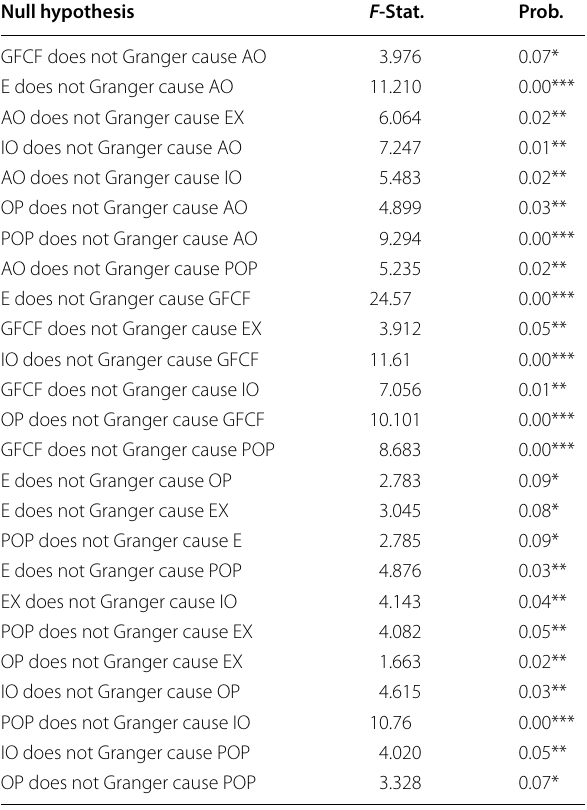
Table 3 Result of Granger causality